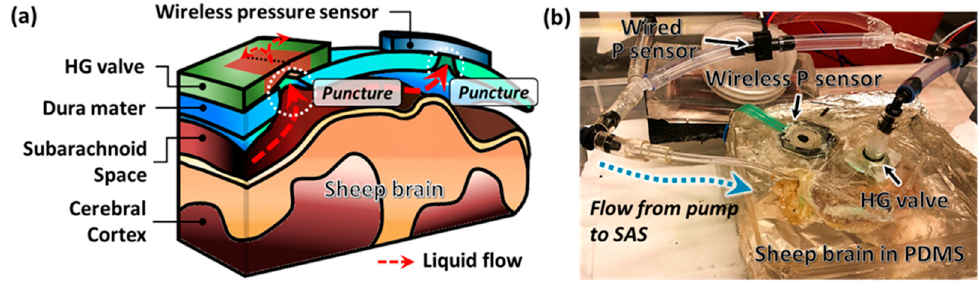
Figure 3. The hydrogel valve was evaluated in an in vitro setting using a fixed sheep brain. ( a ) Sche- matic of the experiment setup. The valve and customized wireless pressure sensor were set in the designated location on the dura mater where we manually punctured through. ( b ) Actual configu- ration of the experimental setup. A syringe pump injected CSF into the cavity formed by SAS and the valve. The excess portion of the manual cut was sealed by PDMS to prevent any leakage. The differential pressure was measured across the valve using conventional wired and novel wireless sensors simultaneously.